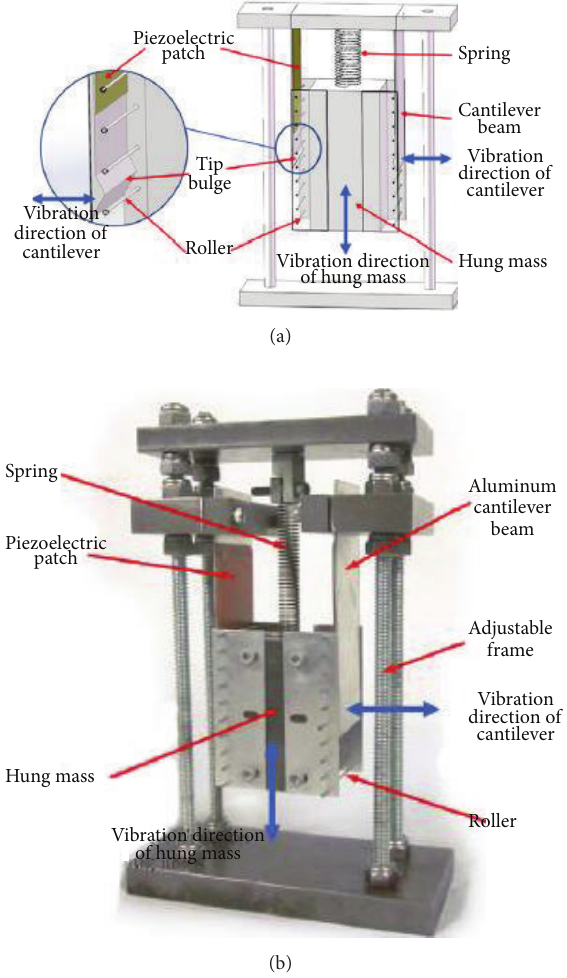
Figure17:Multi-impactPE-VEHdevelopedby[45]:(a)CADmodel and (b) assembled energy